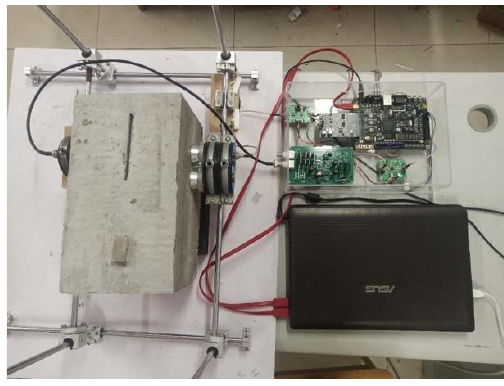
Figure 8. Block II detection position.